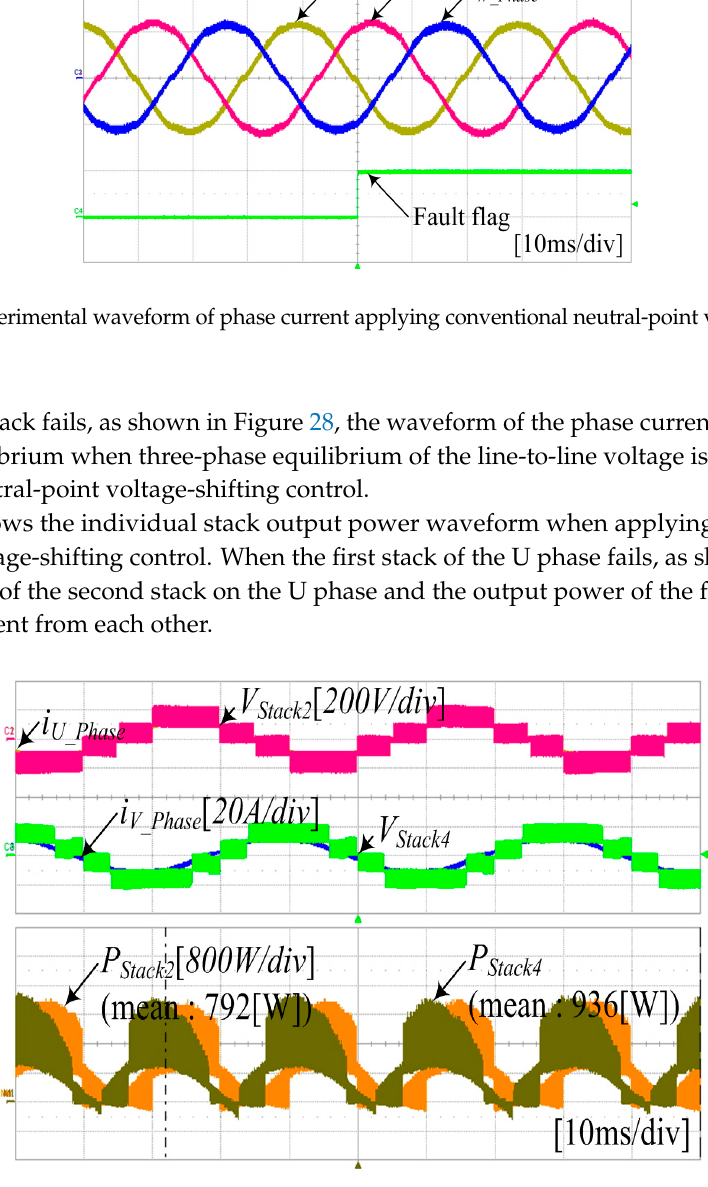
fourth stacks applying the conventional neutral-point voltage-shifting control.